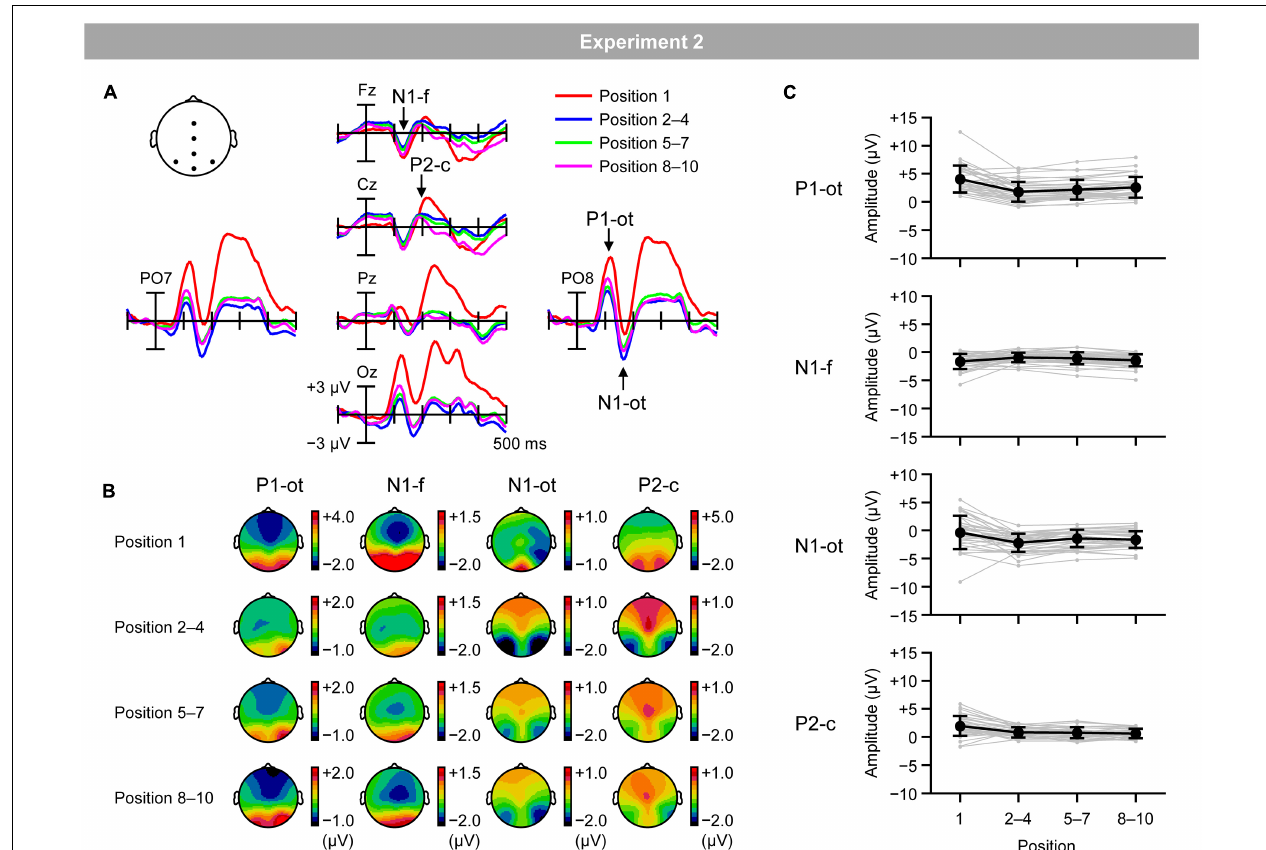
FIGURE 7 | (A) VEPs elicited by inducing stimuli presented at the first position (red lines), second, third, and fourth positions (blue lines), fifth, sixth, and seventh positions (green lines), and eighth, ninth, and tenth positions (purple lines) in the regular trials. (B) Topographical maps of VEPs. (C) Mean (black) and individual (gray) magnitudes of VEPs. P1-ot: occipito-temporal P1, N1-f: frontal N1, N1-ot: occipito-temporal N1, P2-c: central P2. Error bars indicate SD